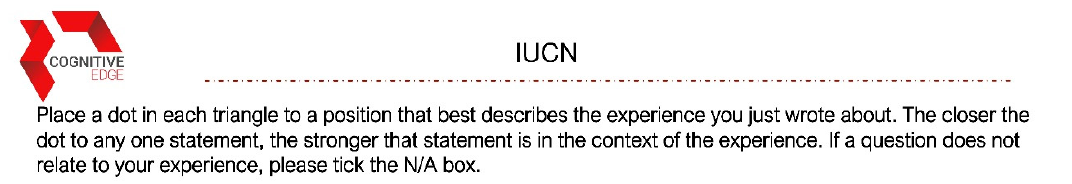
Picture A2: Details about Story Triads Section